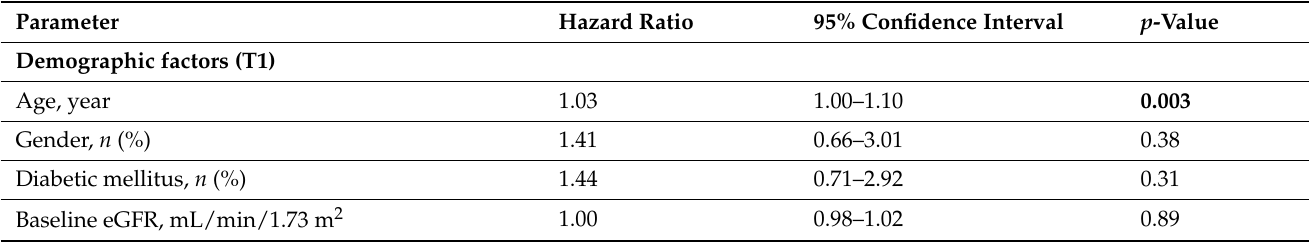
Table 3. Cox proportional hazards models depicting the composite outcome of 90-day mortality or